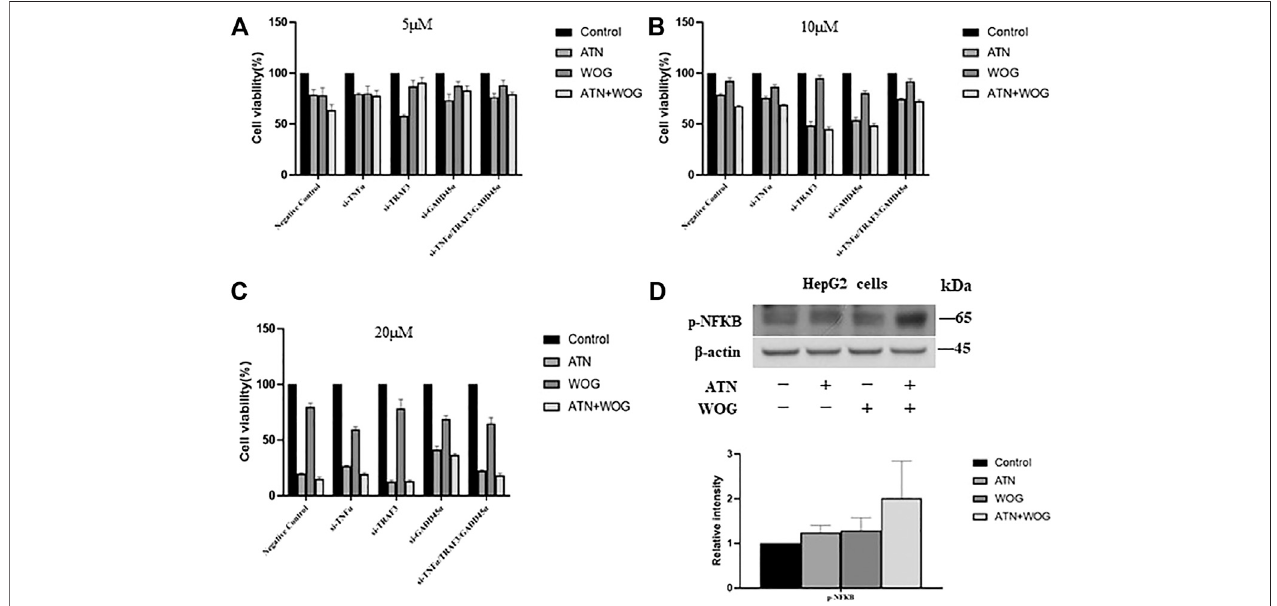
FIGURE5| KnockdownofTNF α ,TRAF3orGADD45 α abolishesthesynergisticeffectofthecombinationtreatmentinreducingtheHCCcellviability.Cellviabilityof TRAF3-knockdown cells (si-TRAF3-HepG2), TNF α -knockdown cells (si-TNF α -HepG2) and GADD45a-knockdown cells (si-GADD45A-HepG2) after treating with (A) . ATN (5 μ M), WOG (5 μ M) or the combination of both for 48 h; or treated with (B). ATN (10 μ M), WOG (10 μ M) or the combination of both; or (C) . ATN (20 μ M), WOG (20 μ M)orthecombinationofbothfor48 h. (D). ExpressionsofphosphorylatedNF κ B( p -NF κ B)inHepG2cellsaftertreatingwithATN(10 μ M),WOG(10 μ M)orthe combination of both for 48 h. Shown is mean ± SE, n (cid:2) 3 independent